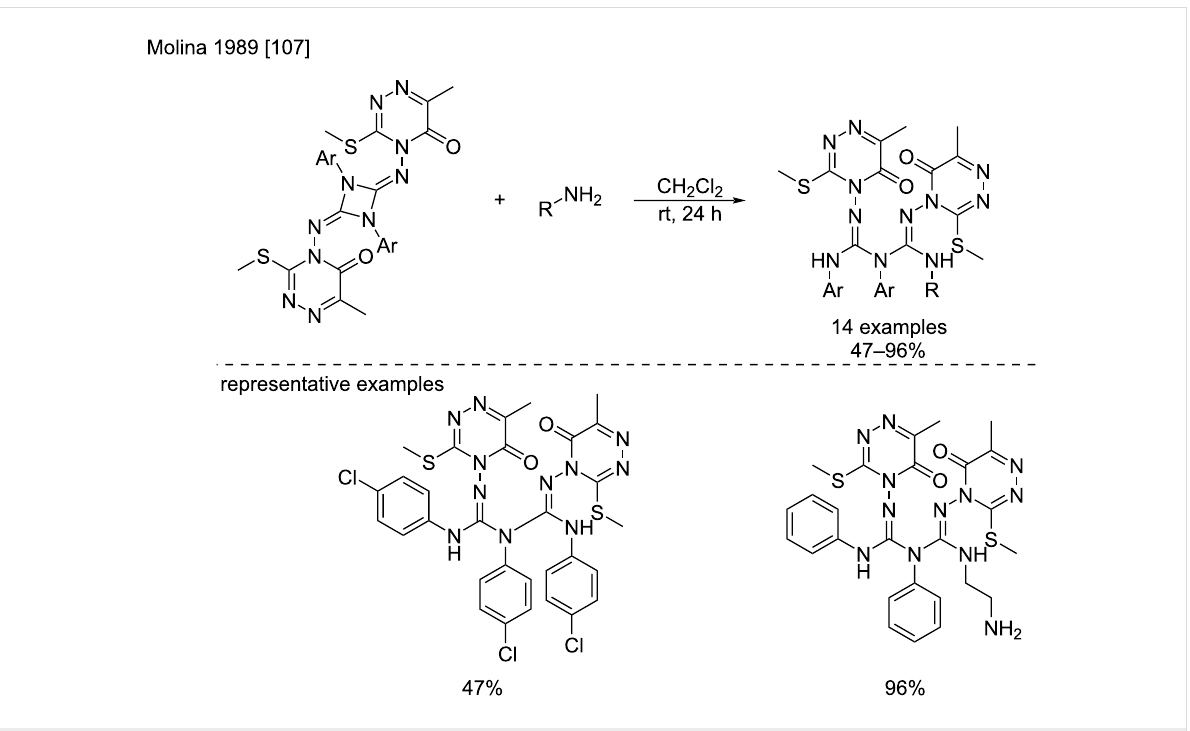
Scheme 60: Ring-opening reactions of 1,3-diaryl-2,4-bis(arylimino)-1,3-diazetidines